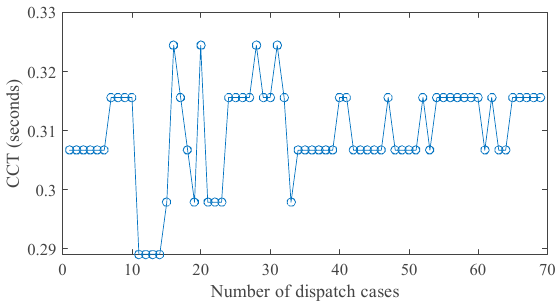
Figure 9. Simulated CCT values under a branch fault contingency.